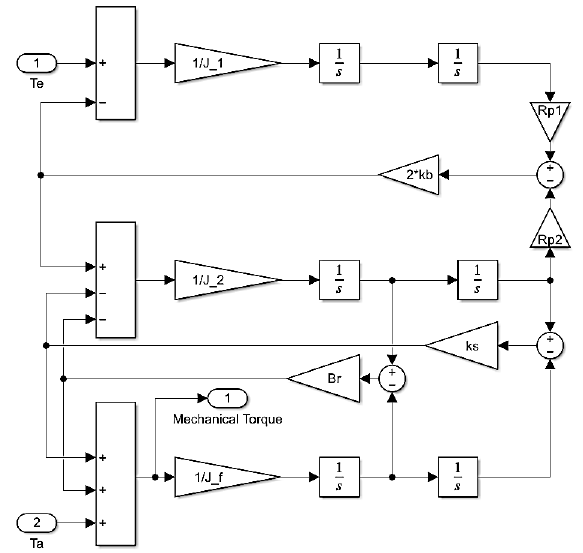
Figure 5. Similink model of the three equations of motions.